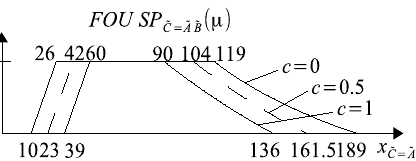
( µ ) of the multiplication result ˜ C = ˜ A ˜ B according to C = ˜ A ˜ B